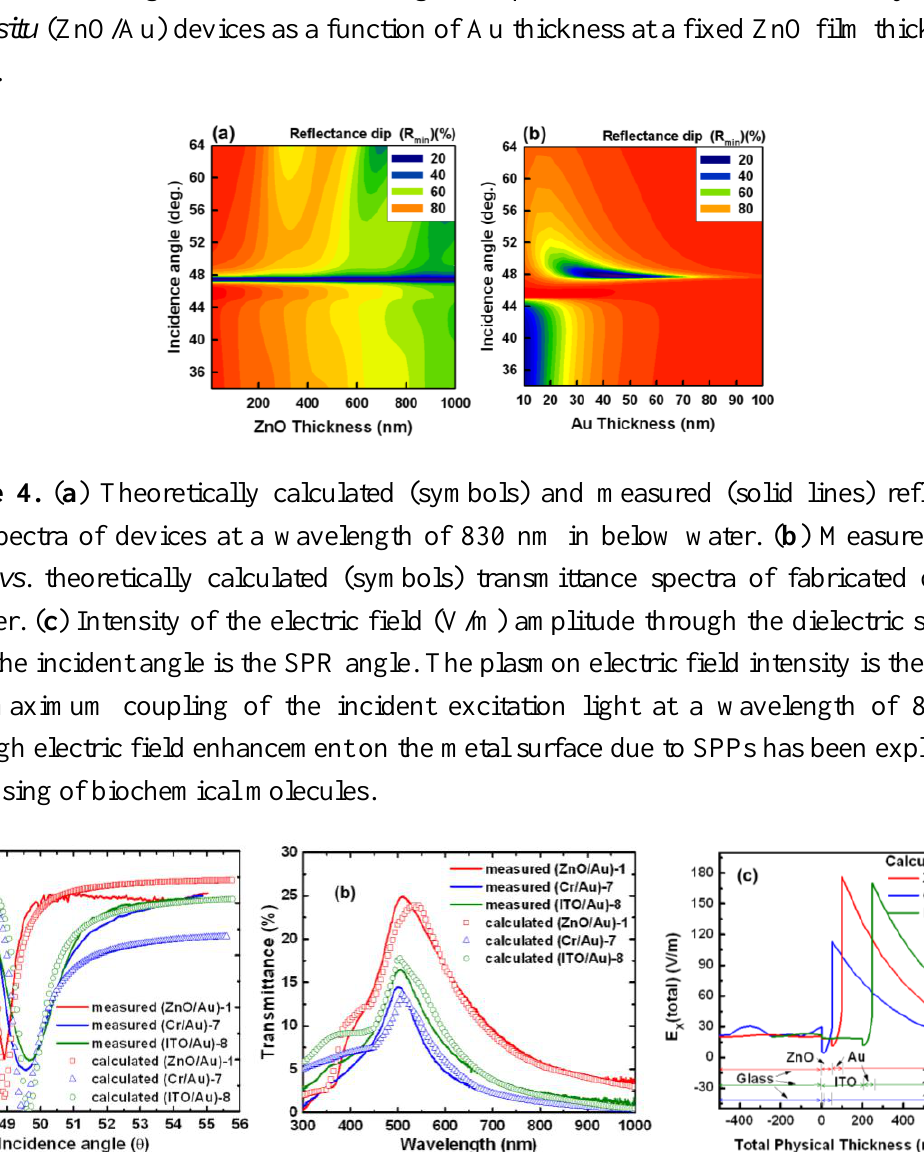
Figure 3. ( a ) Theoretically calculated reflectance SPR spectra of devices in water for a light source with a wavelength of 830 nm. ( b ) Theoretically calculated values at an excitation wavelength of 830 nm showing the dependence of the SPR reflectivity curve of the in situ (ZnO/Au) devices as a function of Au thickness at a fixed ZnO film thickness of 50 nm.